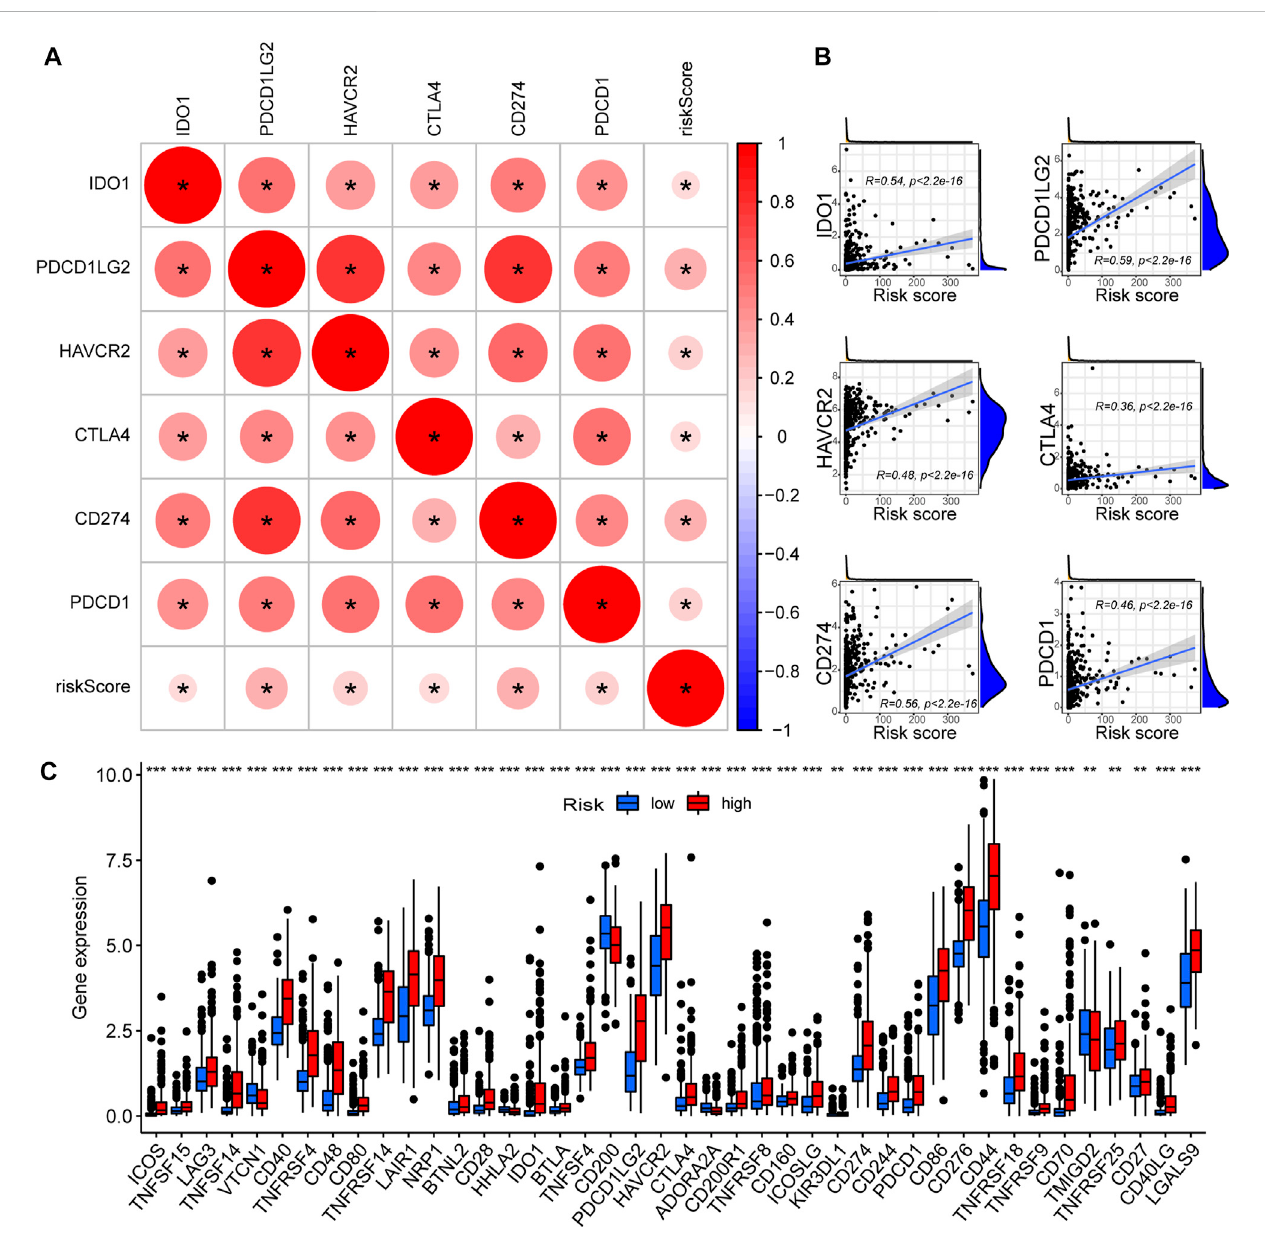
FIGURE 6 High-risk glioma samples possess elevated ICGs expression. (A) The correlation between critical ICGs and risk score; Red color indicates a positive correlation, and a darker color intensity and larger circle represent a stronger correlation. *: p < 0.05. (B) Scatter plots demonstrating the correlation between theriskscoresandtheexpressionlevelsofeachcriticalICGs. (C)